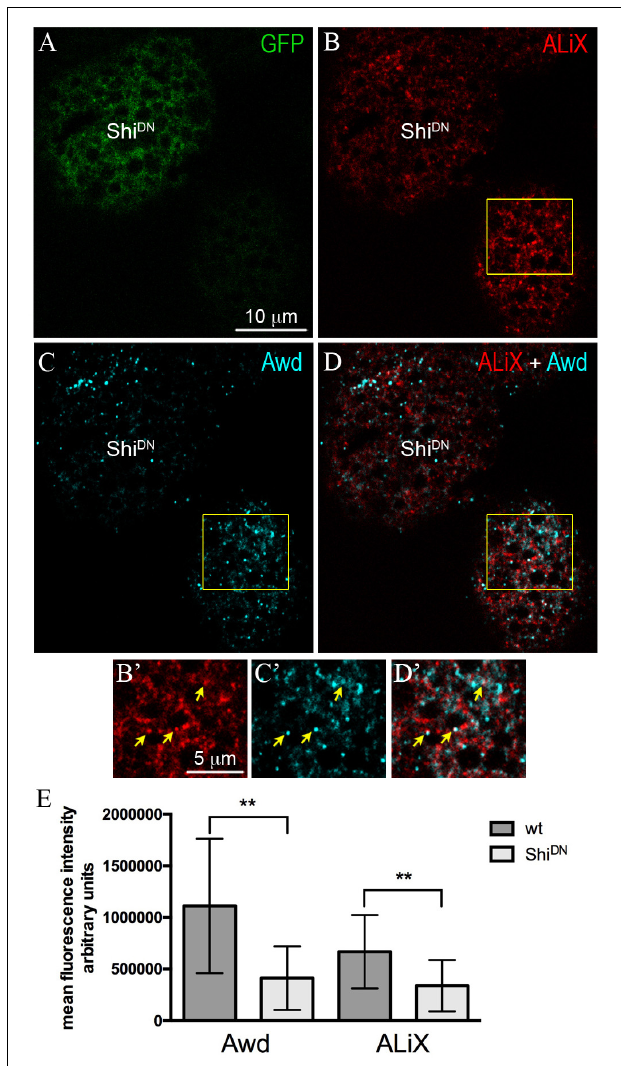
FIGURE 2 | Intracellular distribution of ALiX and Awd in adipocytes expressing Shi DN . (A) Confocal microscopy analysis of fat body containing single-cell flip-out clone (GFP positive, green) over expressing Shi DN . (B) Staining for ALiX (red). (C) Staining for Awd (cyan). (D) merge of B and C signals. (B’ – D’) Magnified view of the wild type adipocyte (yellow box in B – D ). Yellow arrows point to colocalization of ALiX and Awd signals. (E) A significant decrease of Awd ( p = 0.0076) and ALiX ( p = 0.0013) signals is detectable in Shi DN adipocytes. Graphs represent mean ± SD amount of Awd and ALiX in arbitrary units; n = 7; ∗∗ p < 0.01 (two-tailed, paired t-